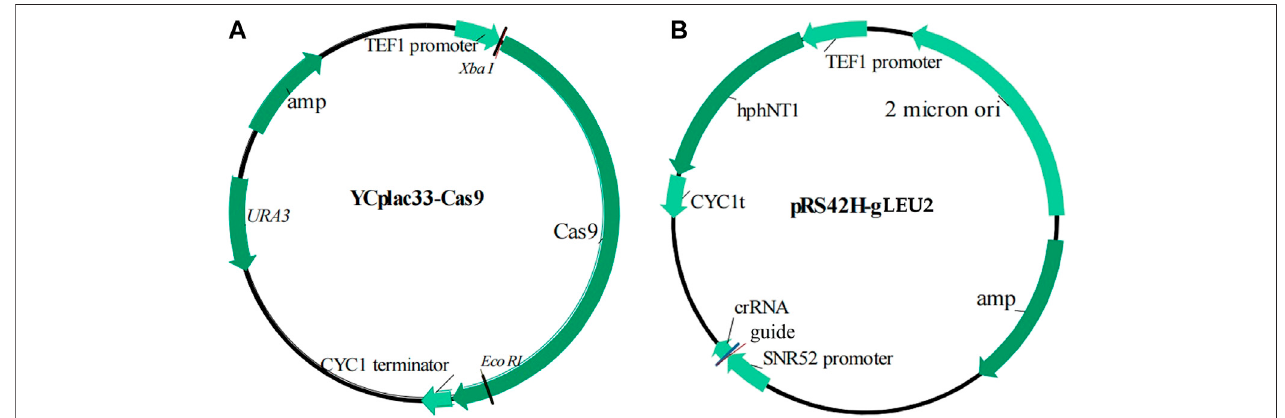
FIGURE 1 | Schematic illustration of plasmids. (A) YCplac33-Cas9; (B)